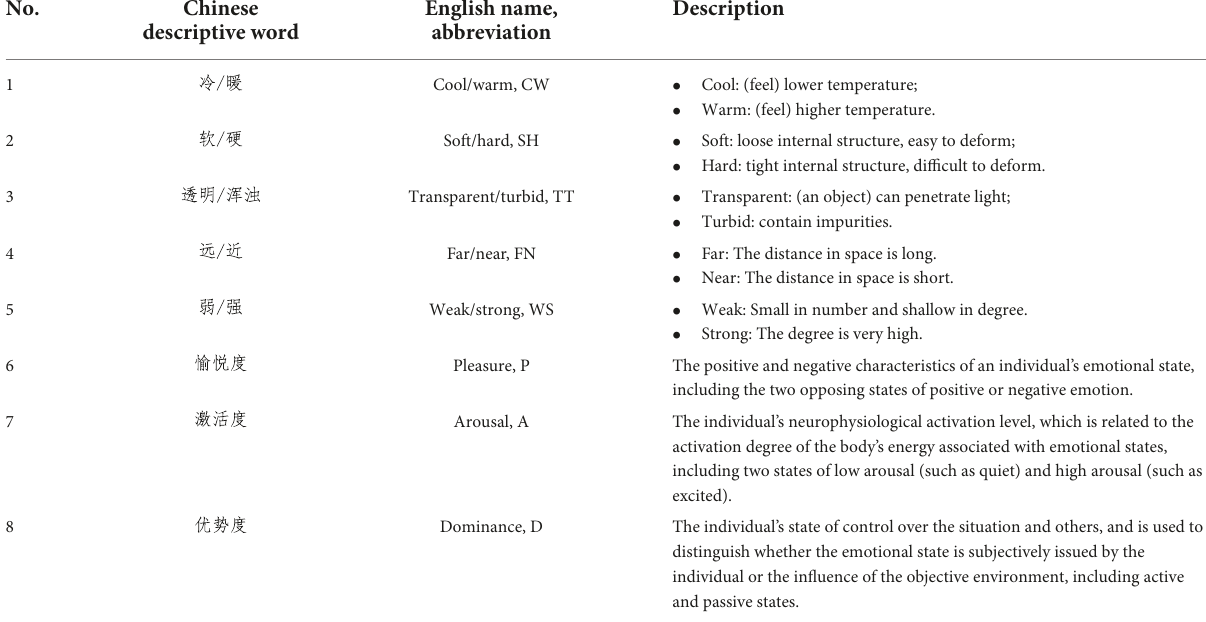
TABLE 1 The selected perceptual descriptive words of multi-color perceptual attributes.